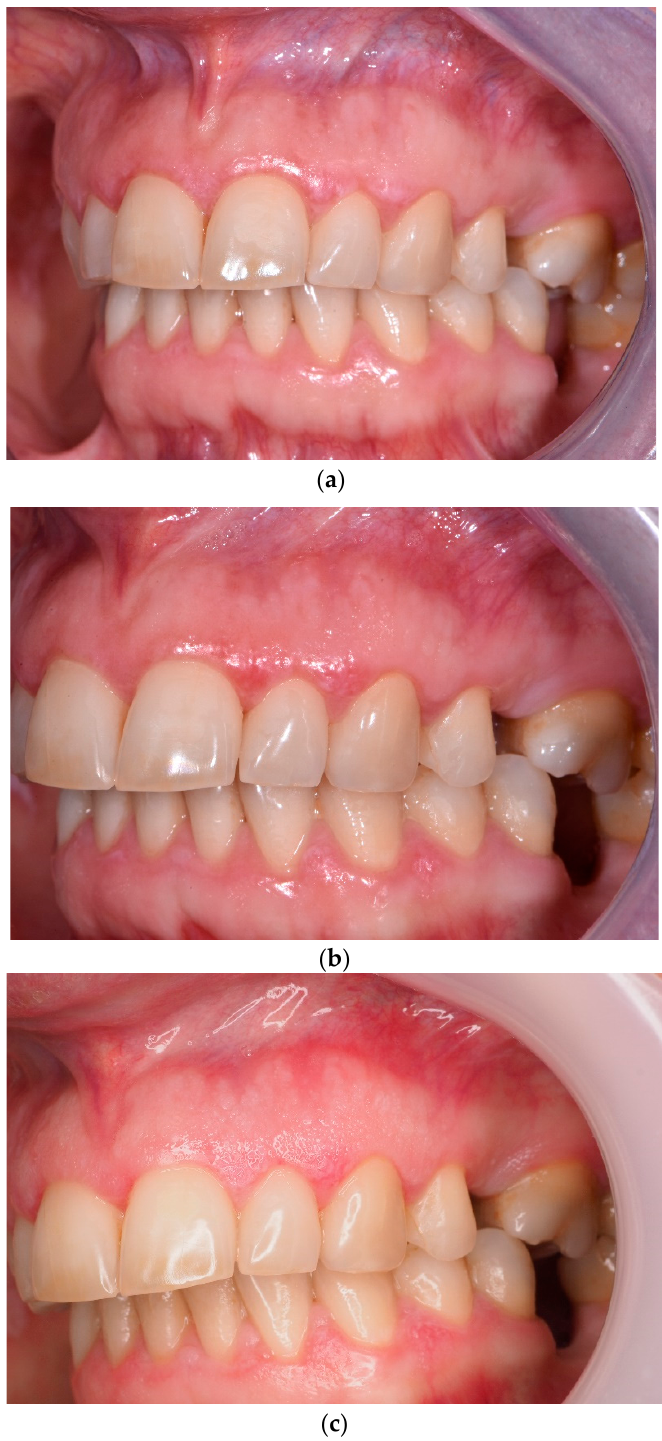
Figure 3. ( a ) Female patient, aged 44, before PDT. OLP on the right gingiva. Size of the lesion—1.1 cm × 0.7 cm; surface area 0.77 cm 2 . ( b ) After PDT—partial remission of the lesion. Size of the remaining lesion—1.1 cm × 0.5 cm; surface area—0.55 cm 2 . ( c ) Twelve months post-op—further improvement in OLP lesion. Size of the remaining lesion—0.5 cm × 0.6 cm; surface area—0.3 cm 2